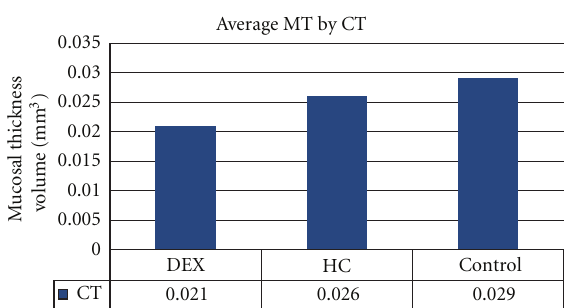
Figure 7: Measuring MT by CT. Measuring mucosal thickness by CT imaging produced measures of MT volume, which is why this bar chart stands alone. The findings, however, are similar to those observed in Figure 6, where DEX-treated chinchillas had less MT thickness compared to the other treatment